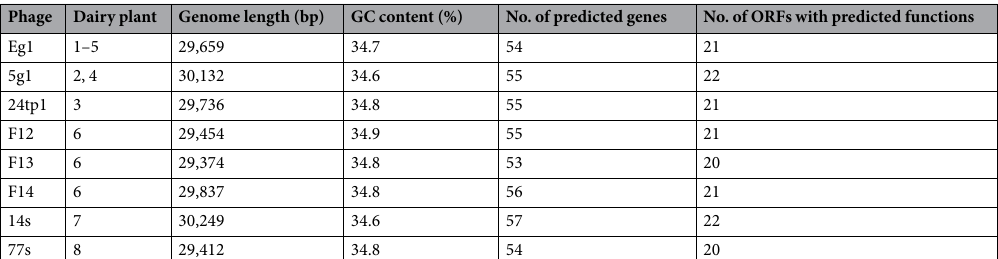
Table 4. Main characteristics of the studied phages based on sequencing